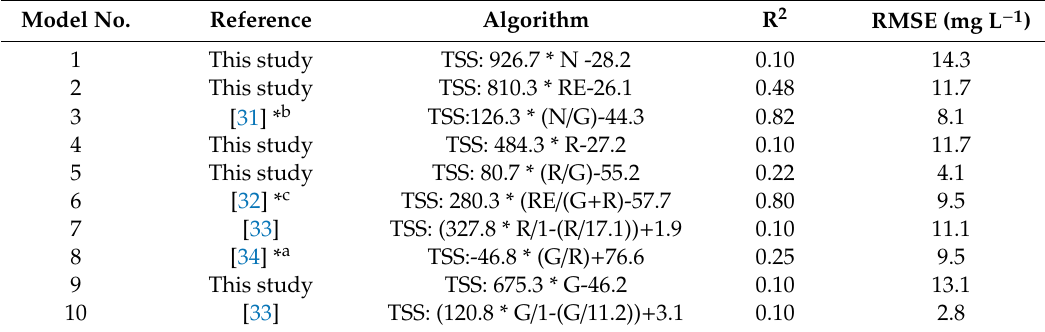
Table 4. TSS bio-optical models and statistical results for the 2018 / 09 / 12 survey. Model No.